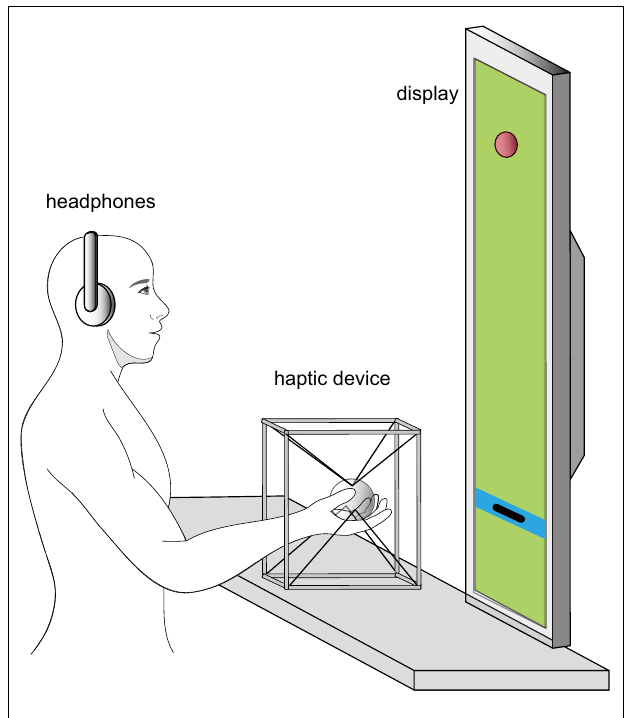
FIGURE 1 | Experiment system. A virtual red ball (radius = 2cm) and a black square cursor (width = 10cm, height = 2cm) projecting the hand position in the vertical direction were displayed on a plasma display. Subjects held a ball-shaped plastic grip attached to a “SPIDAR” haptic device, which consisted of eight motors and strings. Load force was applied through tension in the strings by the motors.The grip position was calculated from angle encoders attached to the motors. Subjects wore a pair of noise-canceling headphones to reduce the sound generated by the motors of the haptic